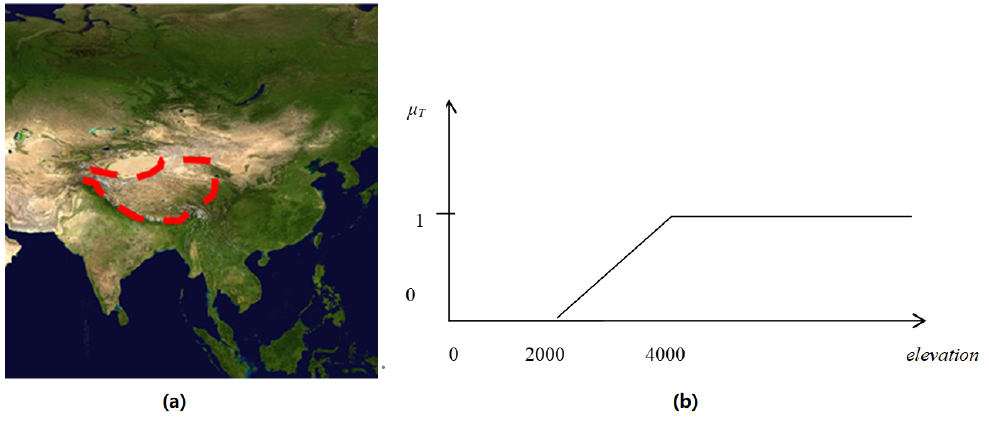
Figure 3. ( a ) The Tibetan Plateau and ( b ) its membership function.